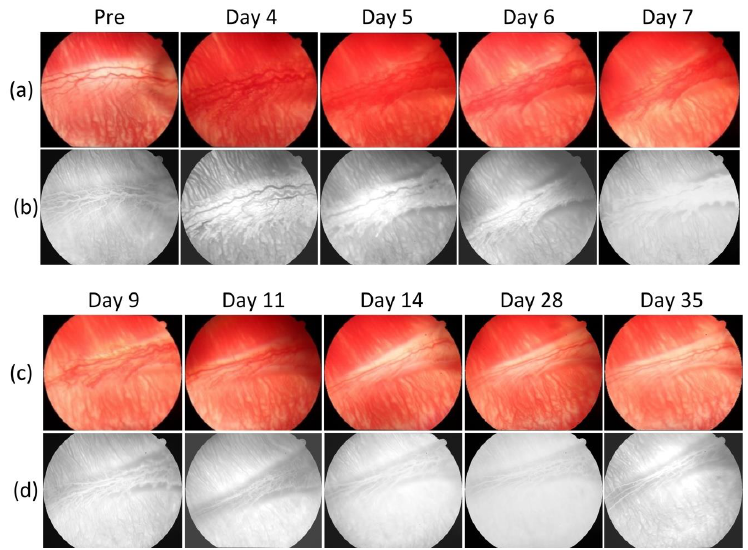
Figure 2. Color fundus photography imaging of retinal blood vessels in rabbits. ( a , c ) Color fundus photography of the retina acquired before and after retinal neovascularization (RNV) model at various times (days 4, 5, 6, 7, 9, 11, 14, 28, and 35). The fundus images show the morphology of retinal and choroidal vessels. ( b , d ) Fluorescein angiography images show retinal and choroidal vessels.